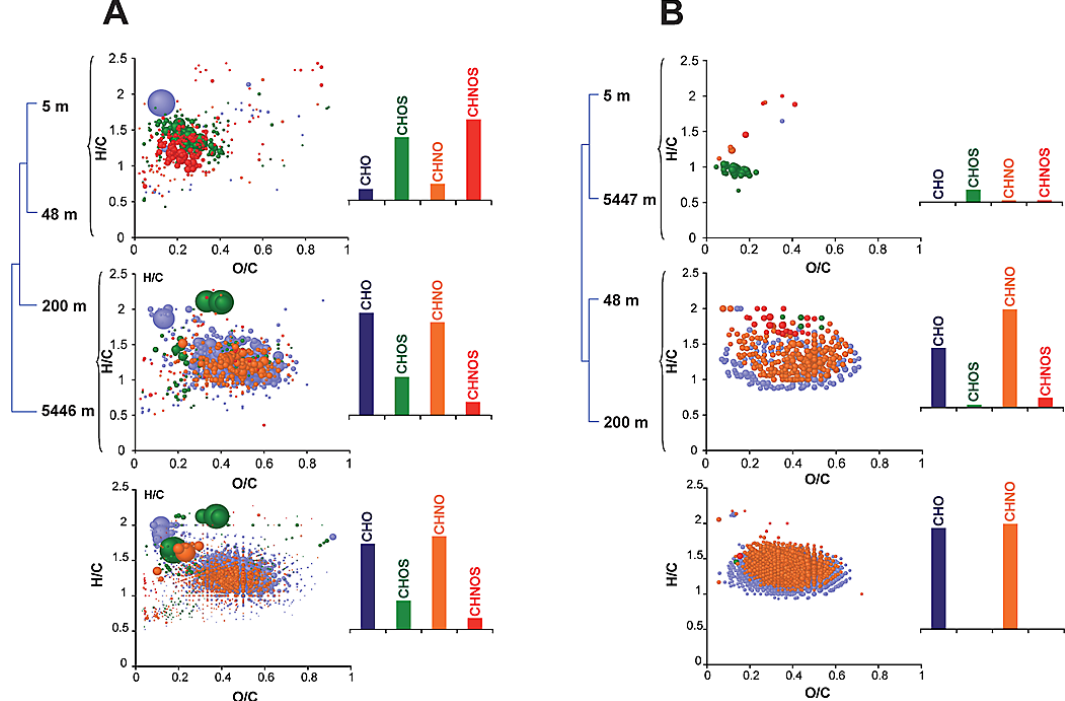
Fig. 17. (A) Negative ESIFTICR mass spectra of marine SPE-DOM; Euclidean clustering diagram based on the similarity values between the merged negative ESIFTICR mass spectra of marine SPE-DOM near surface (5m, 48m) and at depth (200m, 5446m); circular areas indicate relative mass peak intensity. Top and middle row: van Krevelen diagrams of the unique compositions found in 5m/48m SPE-DOM versus 200m/5446m SPE-DOM; bottom row: common ions found in negative ESIFTICR mass spectra of all four marine SPE-DOM. (B) Positive ESIFTICR mass spectra of marine SPE-DOM; Euclidean clustering diagram based on the similarity values between the merged negative ESI FTICR mass spectra of marine SPE-DOM at extreme depths (5m, 5446m) and in between (48m, 200m); circular areas indicate relative mass peak intensity. Top and middle row: van Krevelen diagrams of the unique compositions found in 5m/5446m SPE-DOM versus 48m/200m SPE-DOM; bottom row: common ions found in positive ESIFTICR mass spectra of all four marine SPE-DOM. Note the absence of black sulphur compounds specific to abyssopelagic SPE-DOM at 5446m (Fig. 16b) in the top row of (B) because only unique ions common to both surface and abyssopelagic SPE-DOM are displayed here. Respective right panels: histograms represent relative counts of respective unique and common CHO, CHOS, CHNO and CHNOS molecular series as found in respective van Krevelen